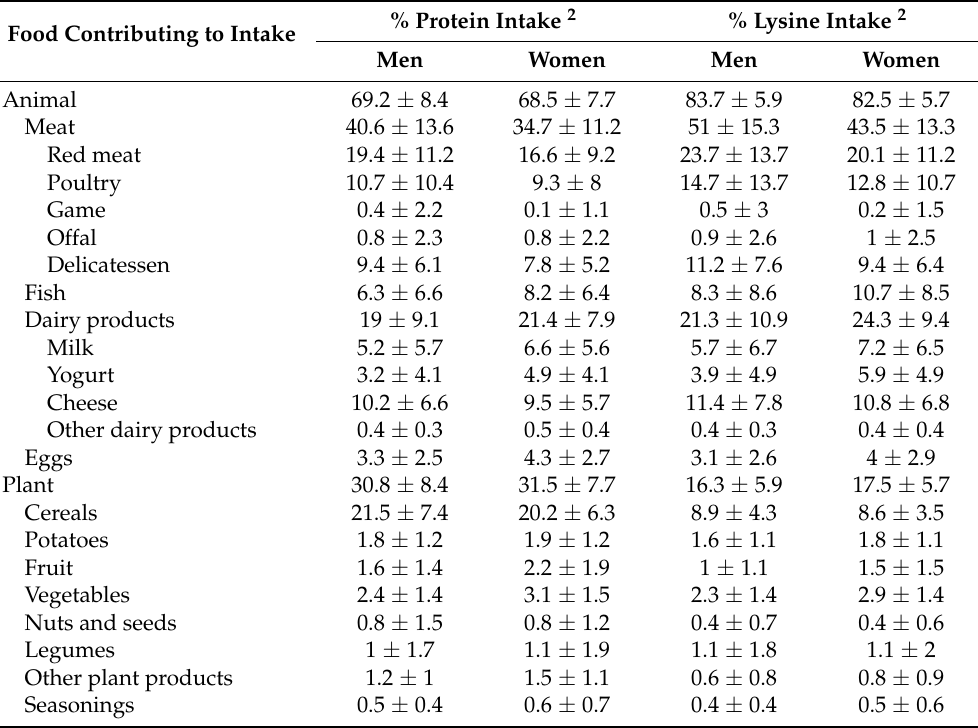
Table 1. Food groups for animal and plant proteins contributing to protein and lysine intake in the French adult population (INCA2 study) 1